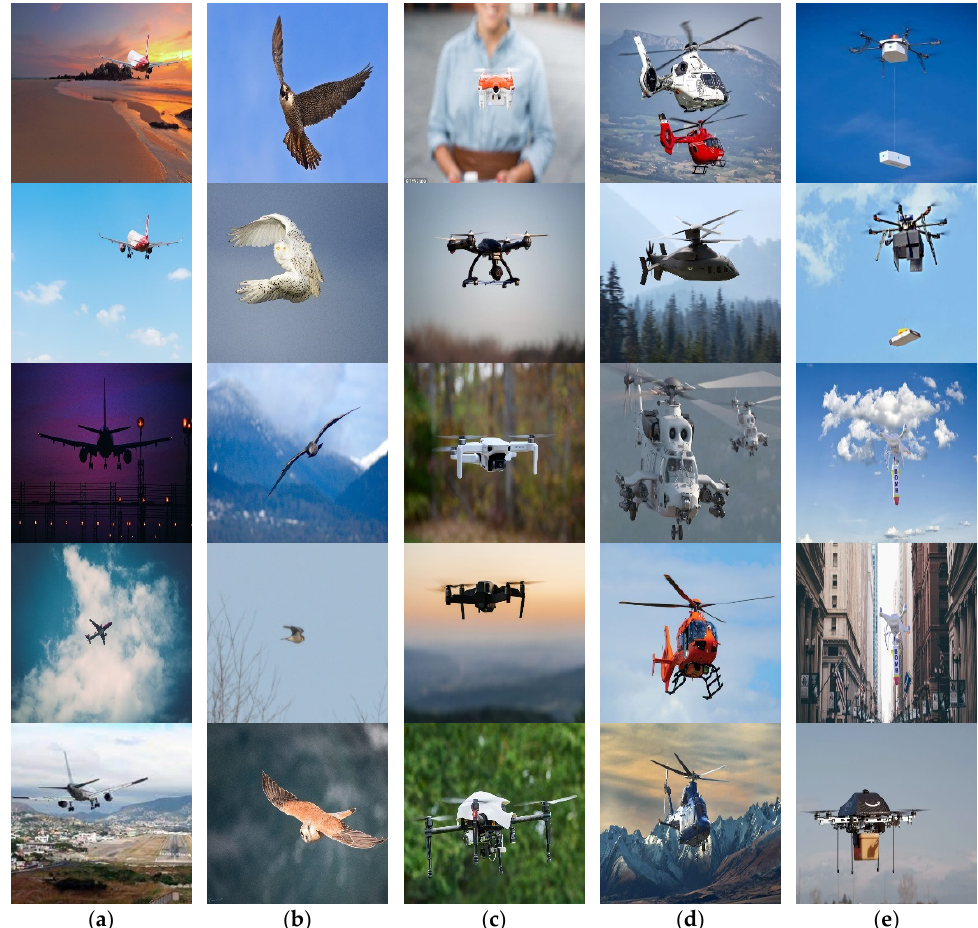
Figure 4. Sample images from the custom dataset for five different classes: ( a ) aeroplane; ( b ) bird; ( c ) drone; ( d ) helicopter; and ( e ) malicious drone.